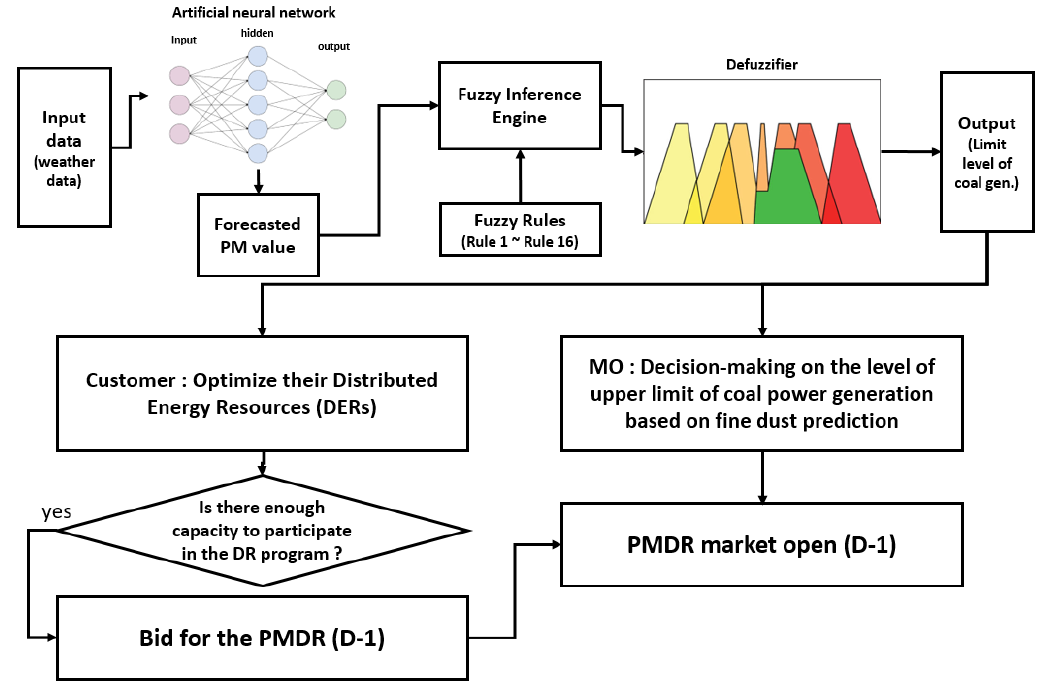
Figure 11. Proposed DR program process.